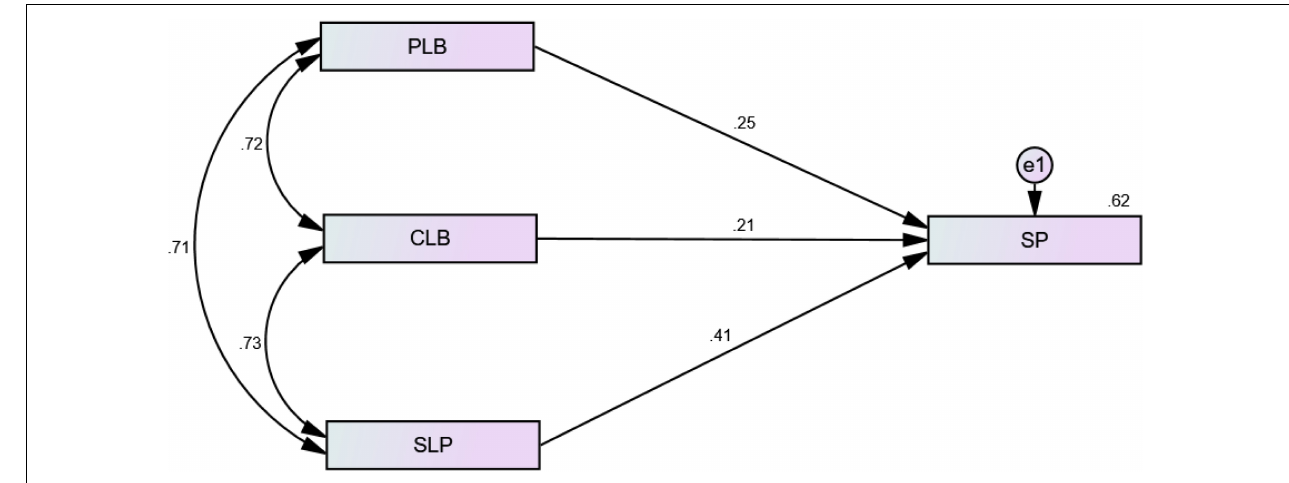
FIGURE 6 | Dimensional analysis of LP with SP.